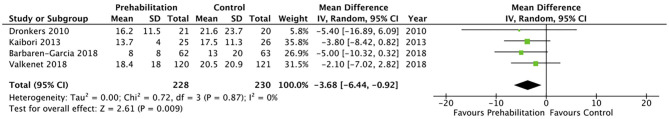
Meta-analysis of hospital length of stay (days).